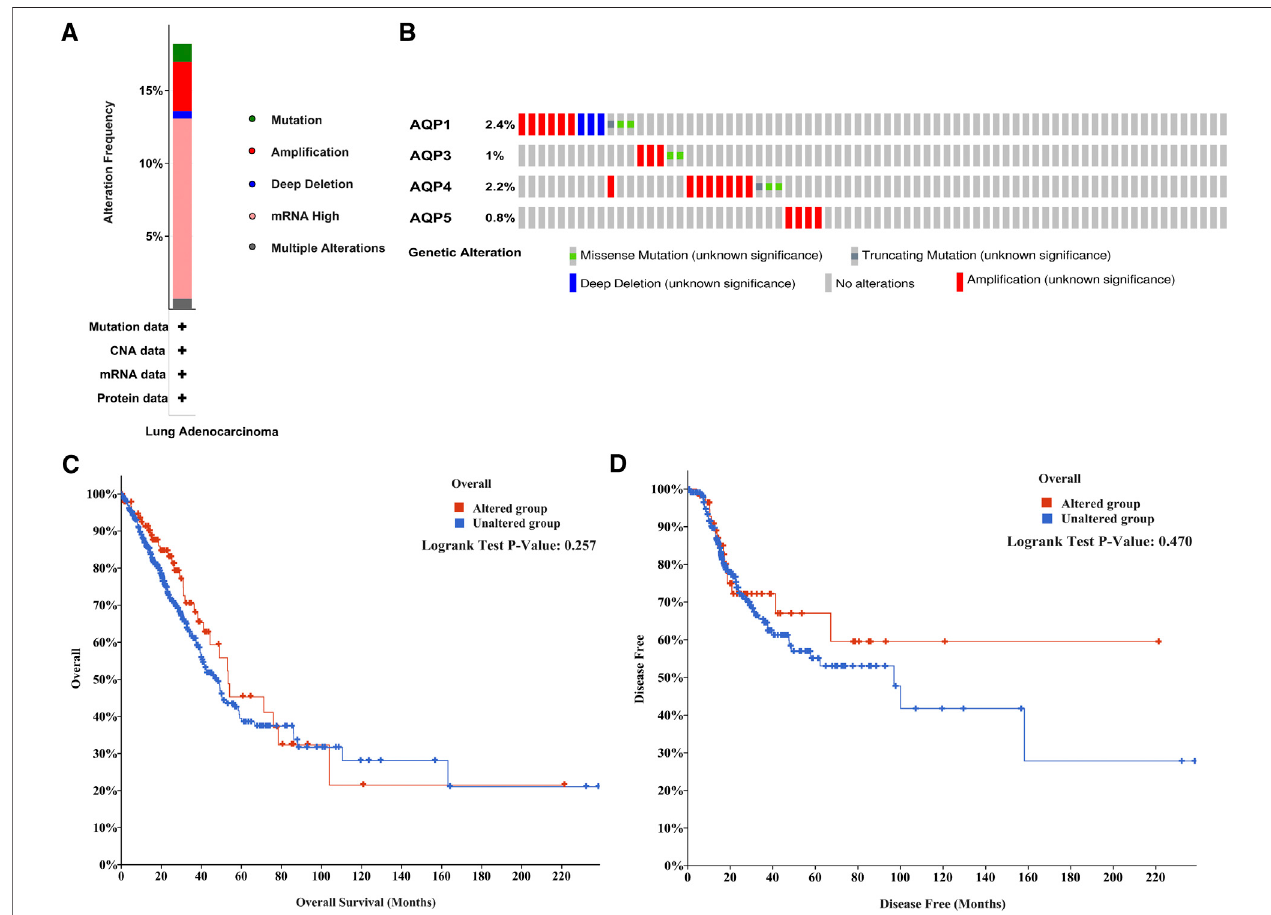
FIGURE 4 | Mutation frequency of AQP family members in LUAD patients with cBioPortal. (A) Mutation frequency in AQP family members. (B) Mutation frequency in the AQP1, AQP3, AQP4, and AQP5 genes. (C,D) Survival analysis associated with AQP gene alterations was performed with the Kaplan – Meier plot.